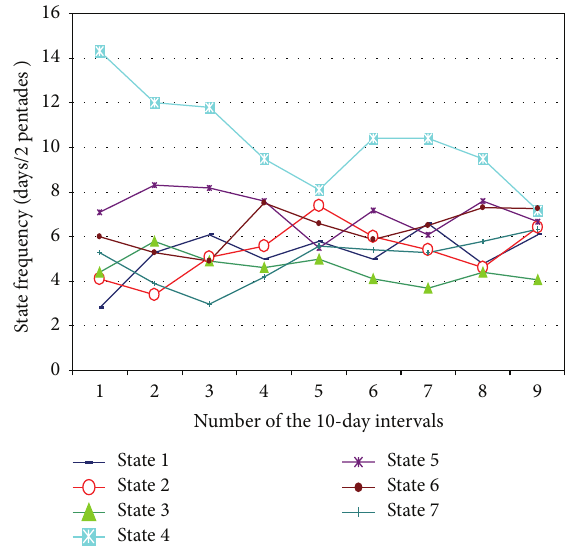
Figure 2: The state frequency in the springtime estimated by Viterbi algorithm.